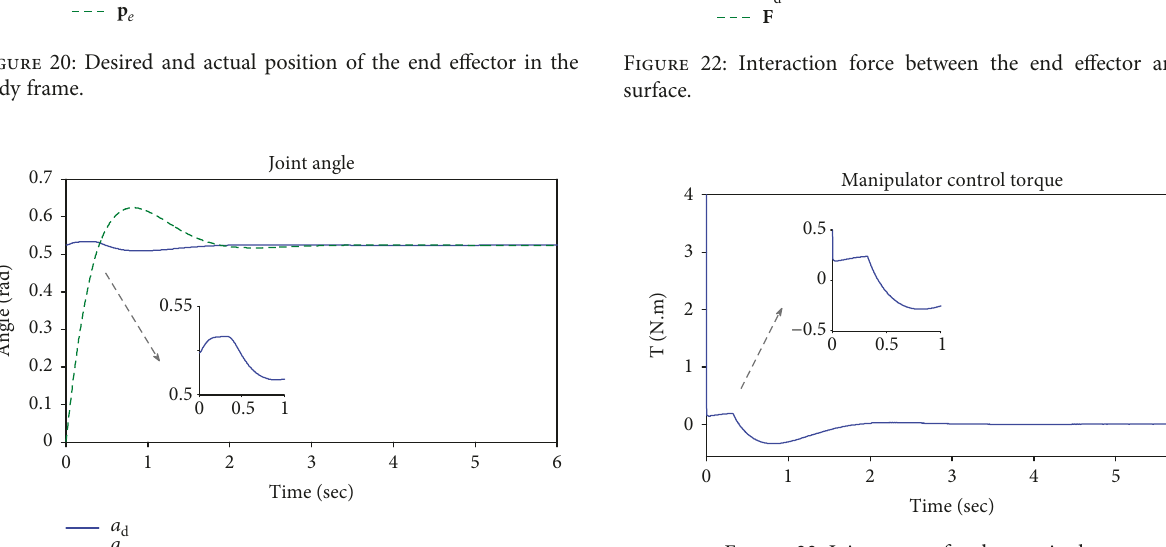
Figure 21: Desired and actual joint angle of the manipulator.